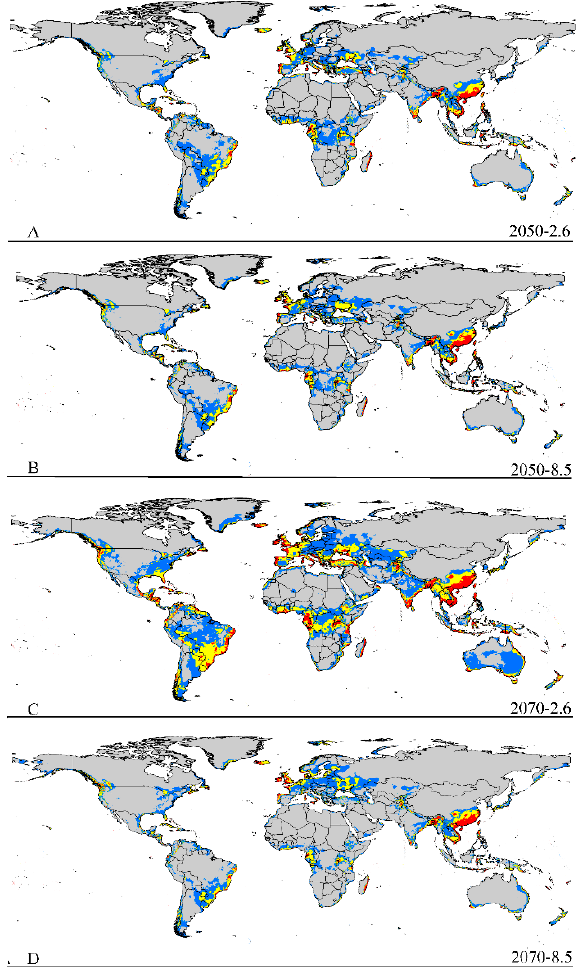
Figure 4. Future species distribution models of Phenacoccus madeirensis on a global scale under different climate scenarios predicated by MaxEnt. Gray, unsuitable habitat area; blue, low habitat suitability area; yellow, moderate habitat suitability area; red, highly habitat suitability area. RCP: Representative Concentration Pathway. ( A ) RCP 2050-2.6; ( B ) RCP 2070-2.6; ( C ) RCP 2050-8.5; ( D ) RCP 2070-8.5.